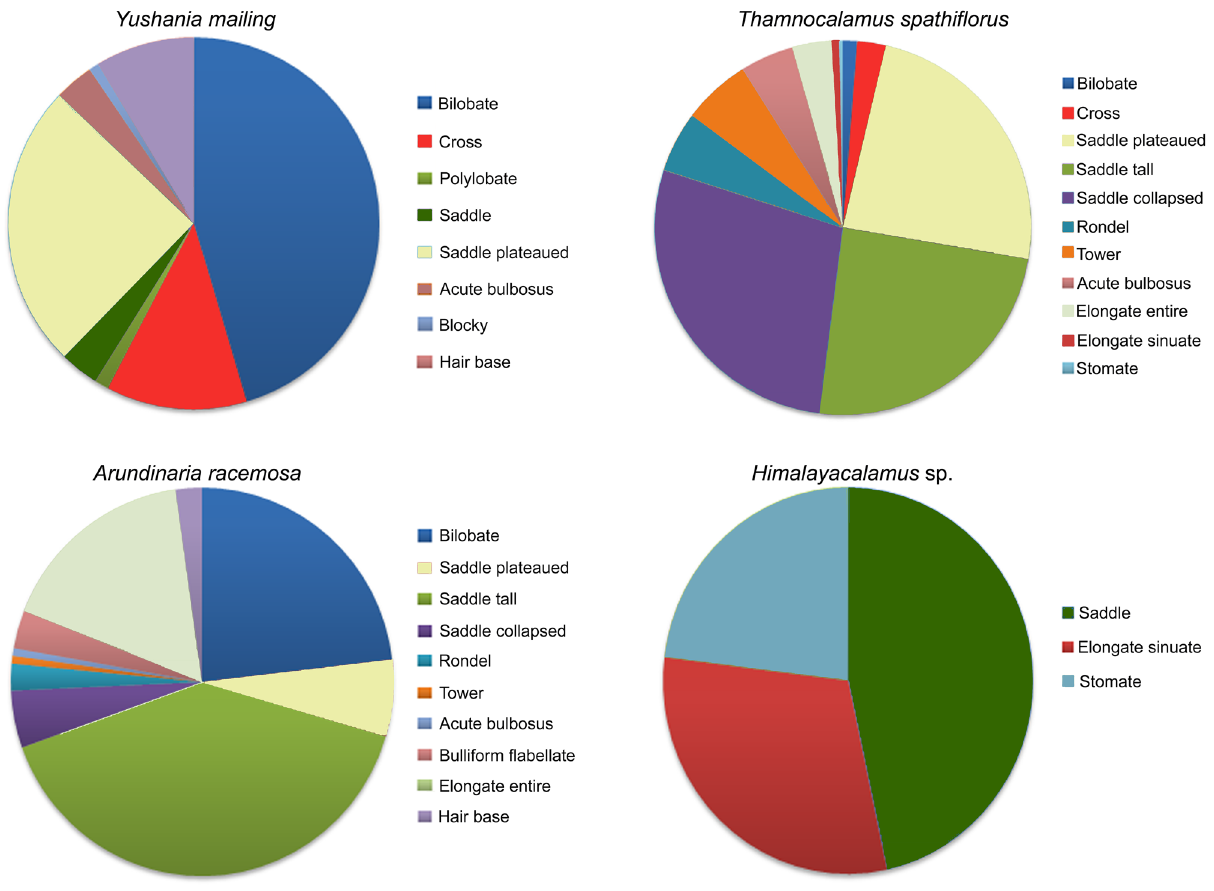
Figure 5. Pie diagrams showing relative abundance of different phytolith types in some dominant Eastern Himalayan bamboo